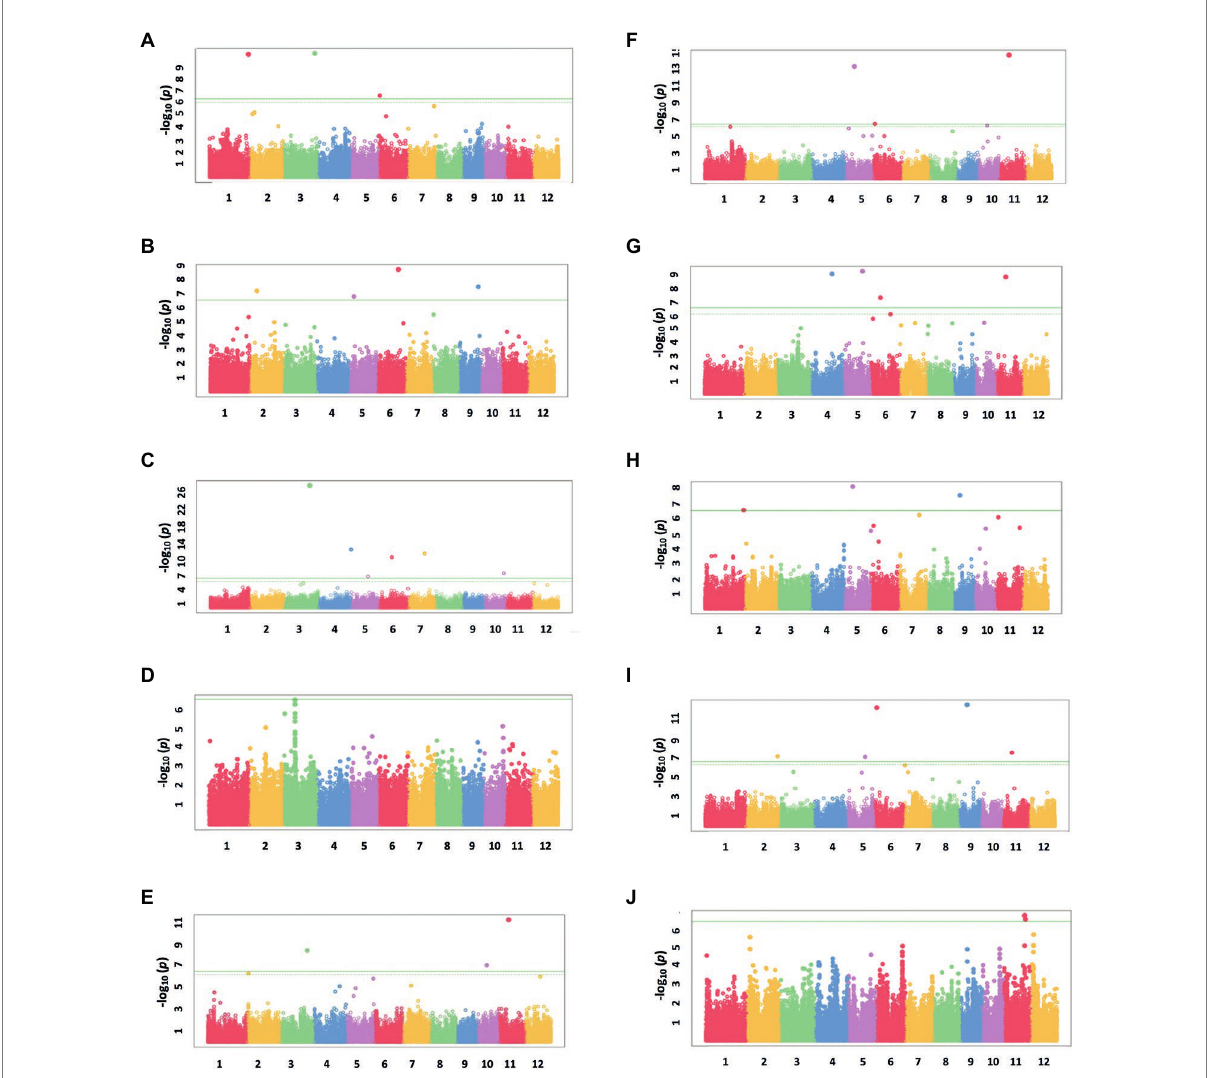
FIGURE 5 Manhattan plots from FarmCPU results. (A) SH at the seedling stage, (B) SFW at the seedling stage, (C) SDW at the seedling stage, (D) F v /F m at the seedling stage, (E) SFW at the vegetative stage, (F) SDW at the vegetative stage, (G) RFW at the vegetative stage, (H) RDW at the vegetative stage, (I) LBS at the vegetative stage, and (J) F v /F m at the vegetative stage. The chromosomal SNPs are differentiated by various colors. The Bonferroni- corrected p = 0.05 and the FDR-corrected p = 0.1 are delineated with a horizontal green line and dashed line,